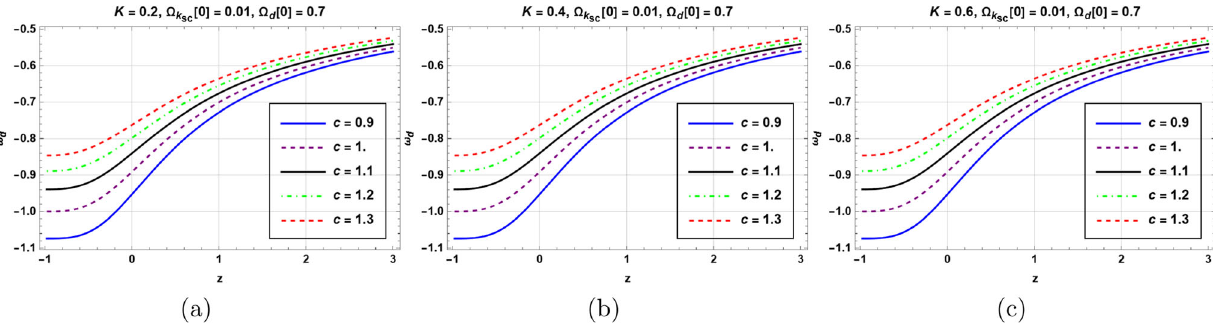
Fig. 3 The variation in the EoS parameter w d with redshift z for the closed universe, in units when M 2 p = 1 , H 0 = 67 . 9. In order to be consistent with data, we now imposed (cid:2) d ( x = − ln ( 1 + z ) = 0 ) = (cid:2) d [ 0 ] = 0 . 7